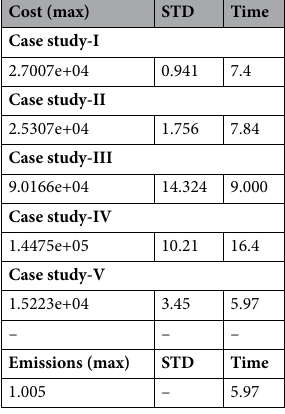
Table 14. Statistical analysis of all case studies.